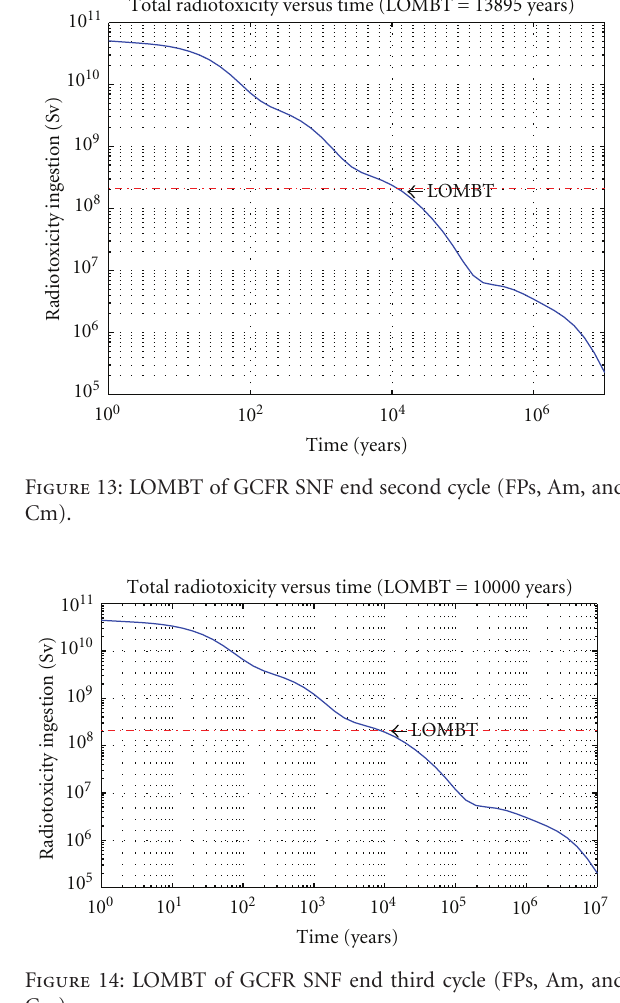
Figure 16: LOMBT of GCFR SNF end fifth cycle (FPs, Am, and Cm).